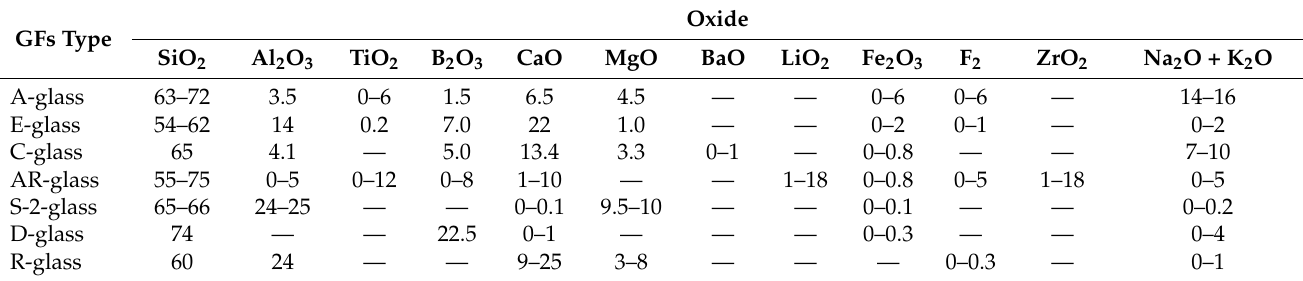
Table 6. Chemical composition of different types of GFs by wt.%